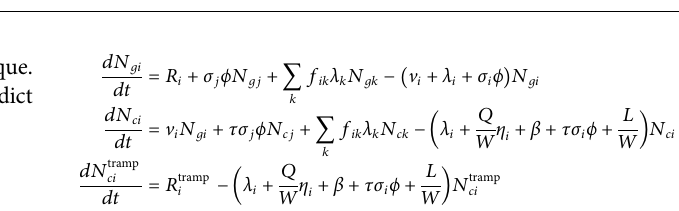
FIGURE 1 | Overview of the fuel failure detection